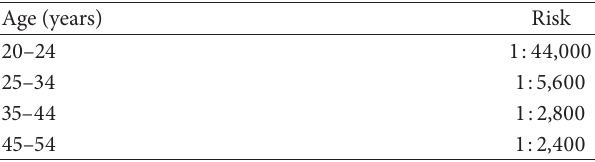
Table 2: Risk of cervical cancer in women with postcoital